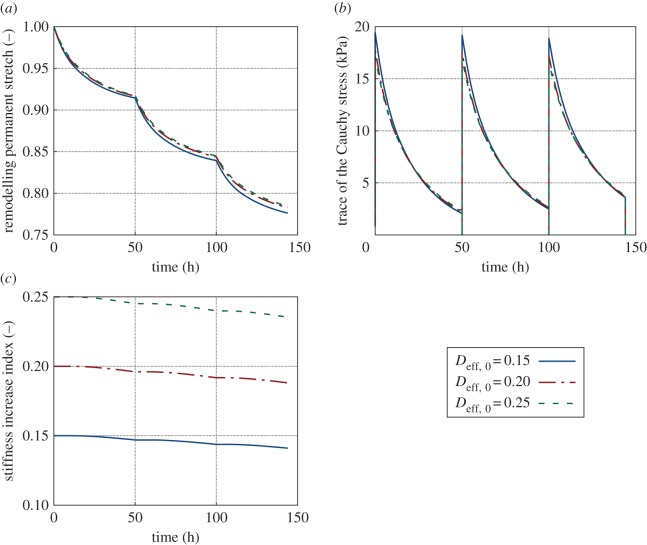
Remodelling permanent stretch, ϑ (a), trace of the Cauchy stress, tr σ (b) and stiffness increase index, Deff (c), at a representative Gauss point of the inner cavity wall. Evolution through three foam changes (at 0, 50 and 100 h) considering an initial stiffness increase index Deff,0 of 0.15, 0.20 or 0.25.